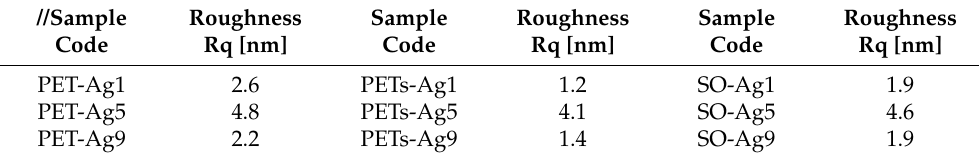
Table 3. Roughness of ultrathin films deposited on PET, thin PET, and optical glass (SO).